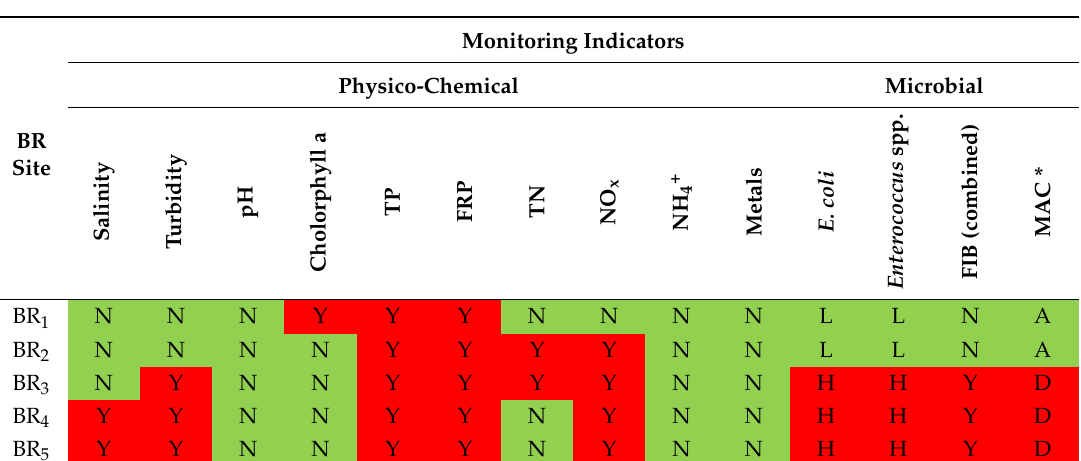
Table 7. Physico-chemical and microbial water quality